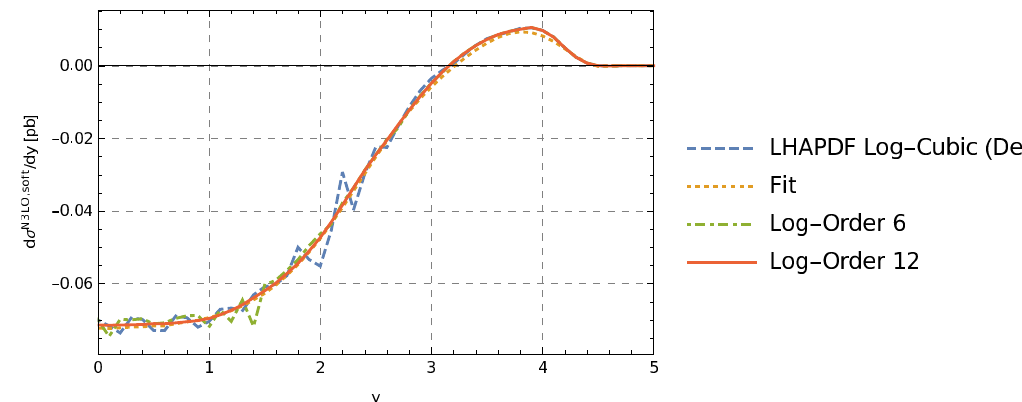
Figure 6. Soft-virtual term of the N3LO correction to the absolute rapidity distribution evaluated with various ways of interpolating the PDF grid. The dashed blue line shows again the default LHAPDF setup and the dashed yellow line shows again the (cid:12)t for comparison. The dashed green line shows our interpolator using order 6 polynomials in log( x ) space. The orange line shows the interpolator with order 12 polynomials in log( x )